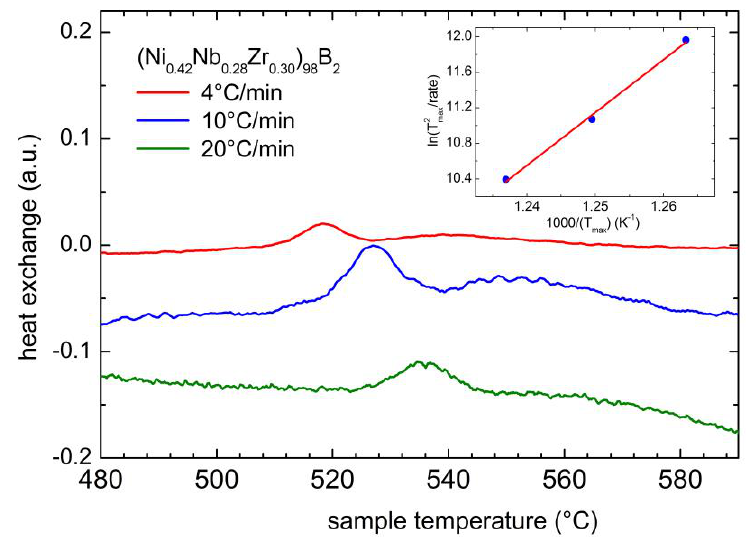
Figure 5. DTA measurements of (Ni 0.42 Nb 0.28 Zr 0.30 ) 98 B 2 measured at various temperature rates. The inset shows the Kissinger plot for the crystallization peak and the best fit line.